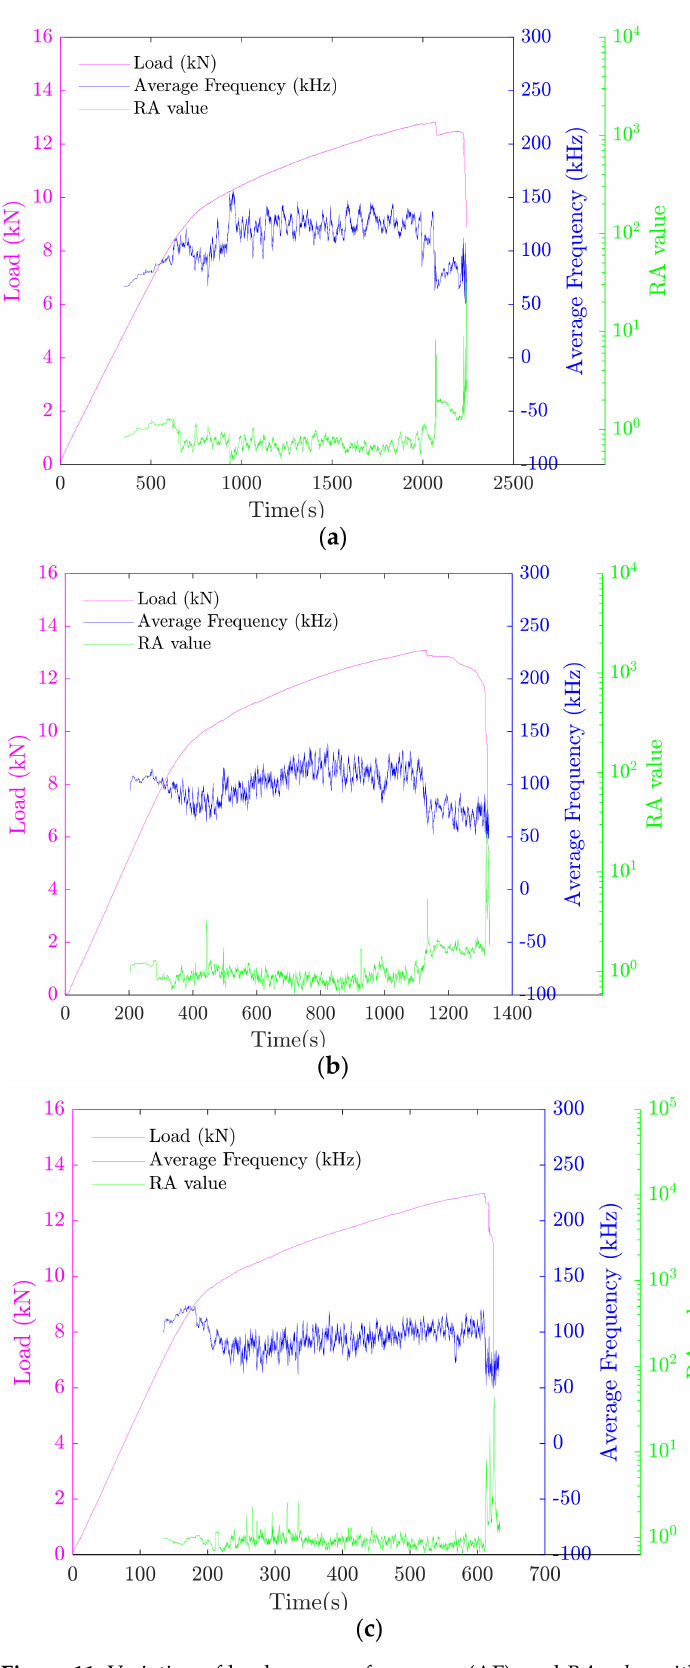
Figure 11. Variation of load, average frequency (AF), and RA value with respect to time: ( a ) sample 1, ( b ) sample 2, and ( c ) sample